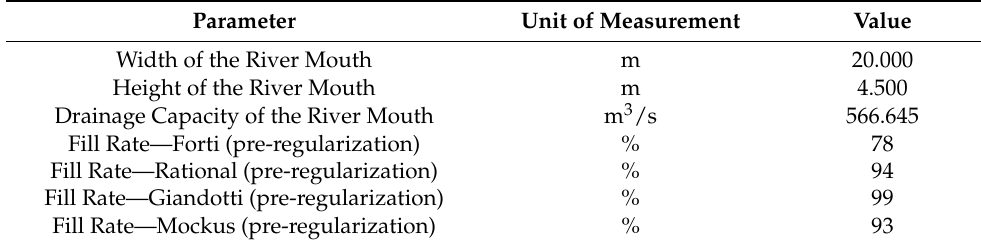
Table 6. Assessment of the need for detention basin